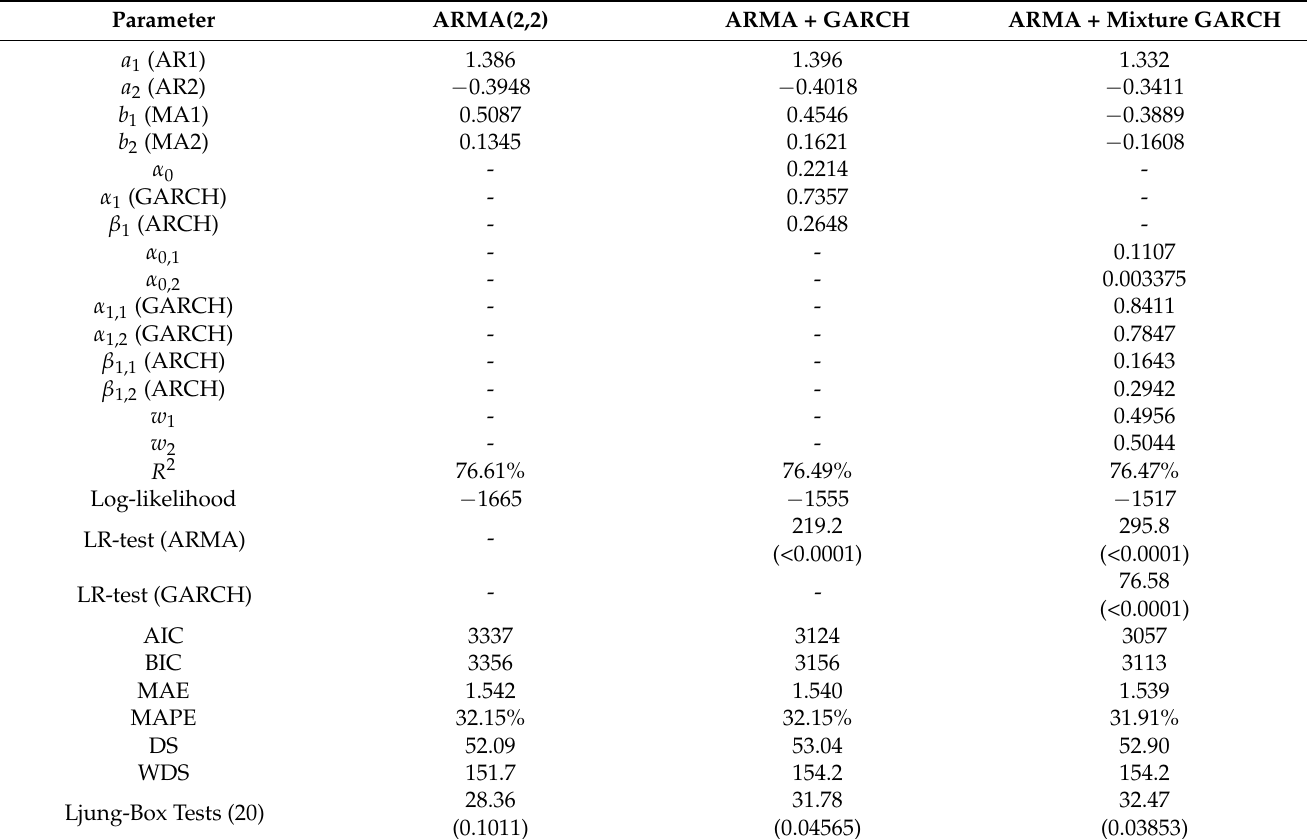
Table 3. Estimated parameters and performance measures for the third wind speed data